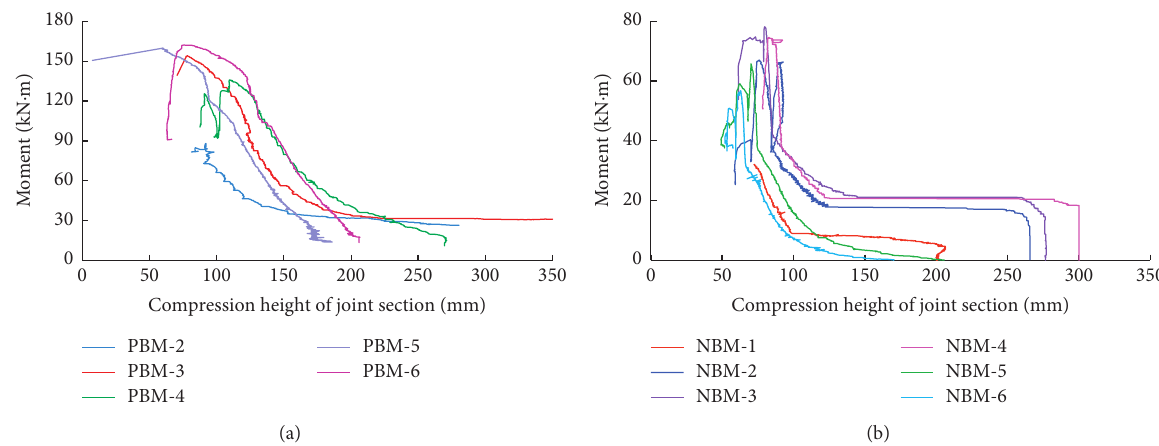
Figure 4: Relationship between compression height of joint section and moment under (a) PBM and (b) NBM. Each curve represents the test results of one test group.